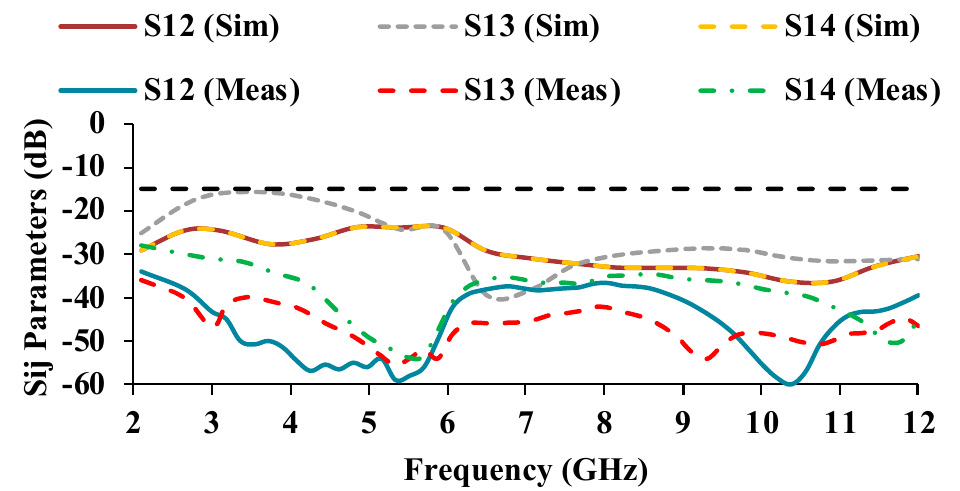
Figure 11. Simulated and measured mutual coupling plots of the MIMO antenna.